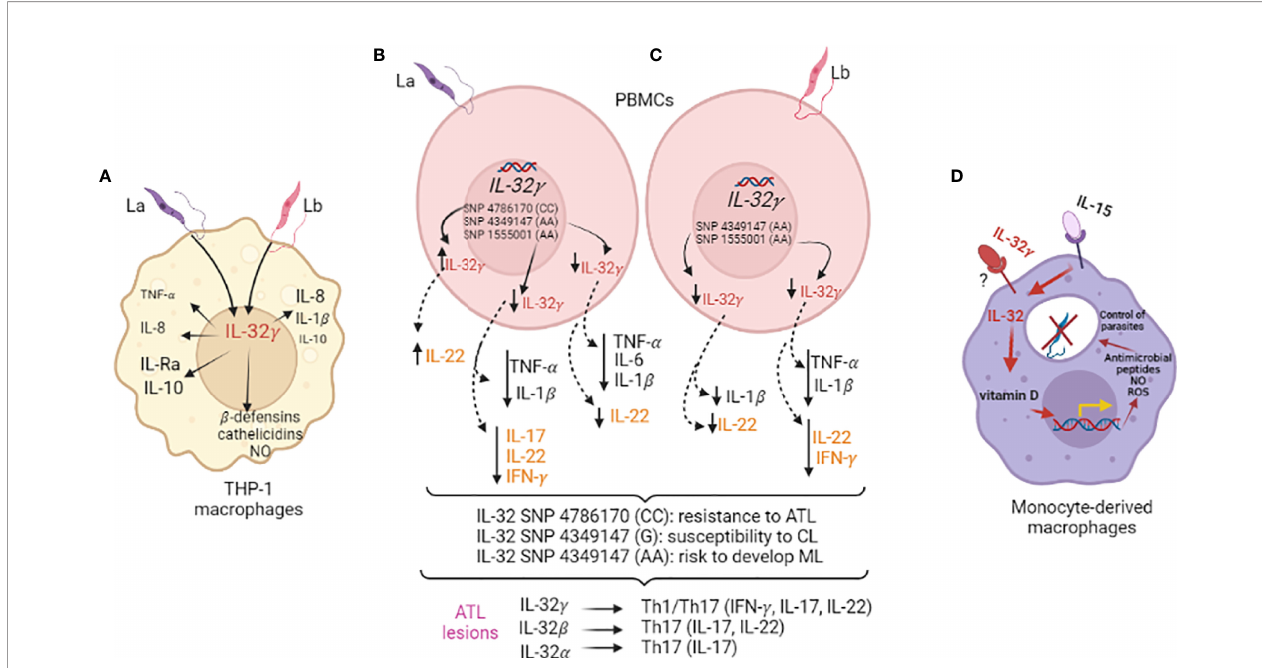
FIGURE 1 | Interleukin-32 in Leishmania infections. (A) Human macrophages derived from the monocyte cell line THP-1 were infected with L. amazonensis (La) or L. braziliensis (Lb) (MOI 5:1) after IL-32 g silencing (siRNA) or overexpression (plasmid) for evaluation of cytokine and antimicrobial molecules. (B, C) PBMCs from healthy individuals genotyped for three IL32 variants were exposed to La (B) or Lb (C) promastigote lysates for cytokine evaluation (innate - TNF- a , IL-1 b , IL-6/24 h; acquired immunity: IL-22, IL-17, IFN- g /seven days) and association with ATL and its clinical outcome; expression of cytokines and different IL-32 isoforms were evaluated in lesions of ATL patients and positive correlations were obtained. (D) Human monocyte-derived macrophages were infected with Lb after priming with recombinant cytokines - IL-15 (inducer of IL-32) and/or IL-32 g to evaluate vitamin D-dependent microbicidal pathway and NO and ROS